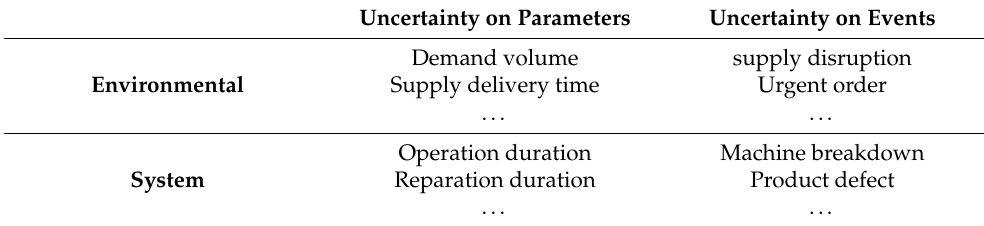
Table 1. Uncertainty